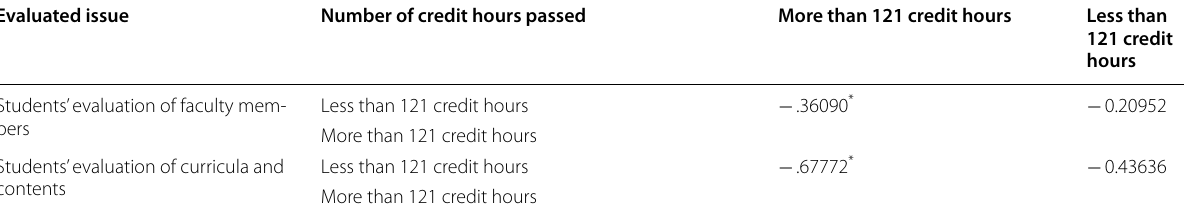
Table 7 LSD test of the principal components between the means of the credit hours